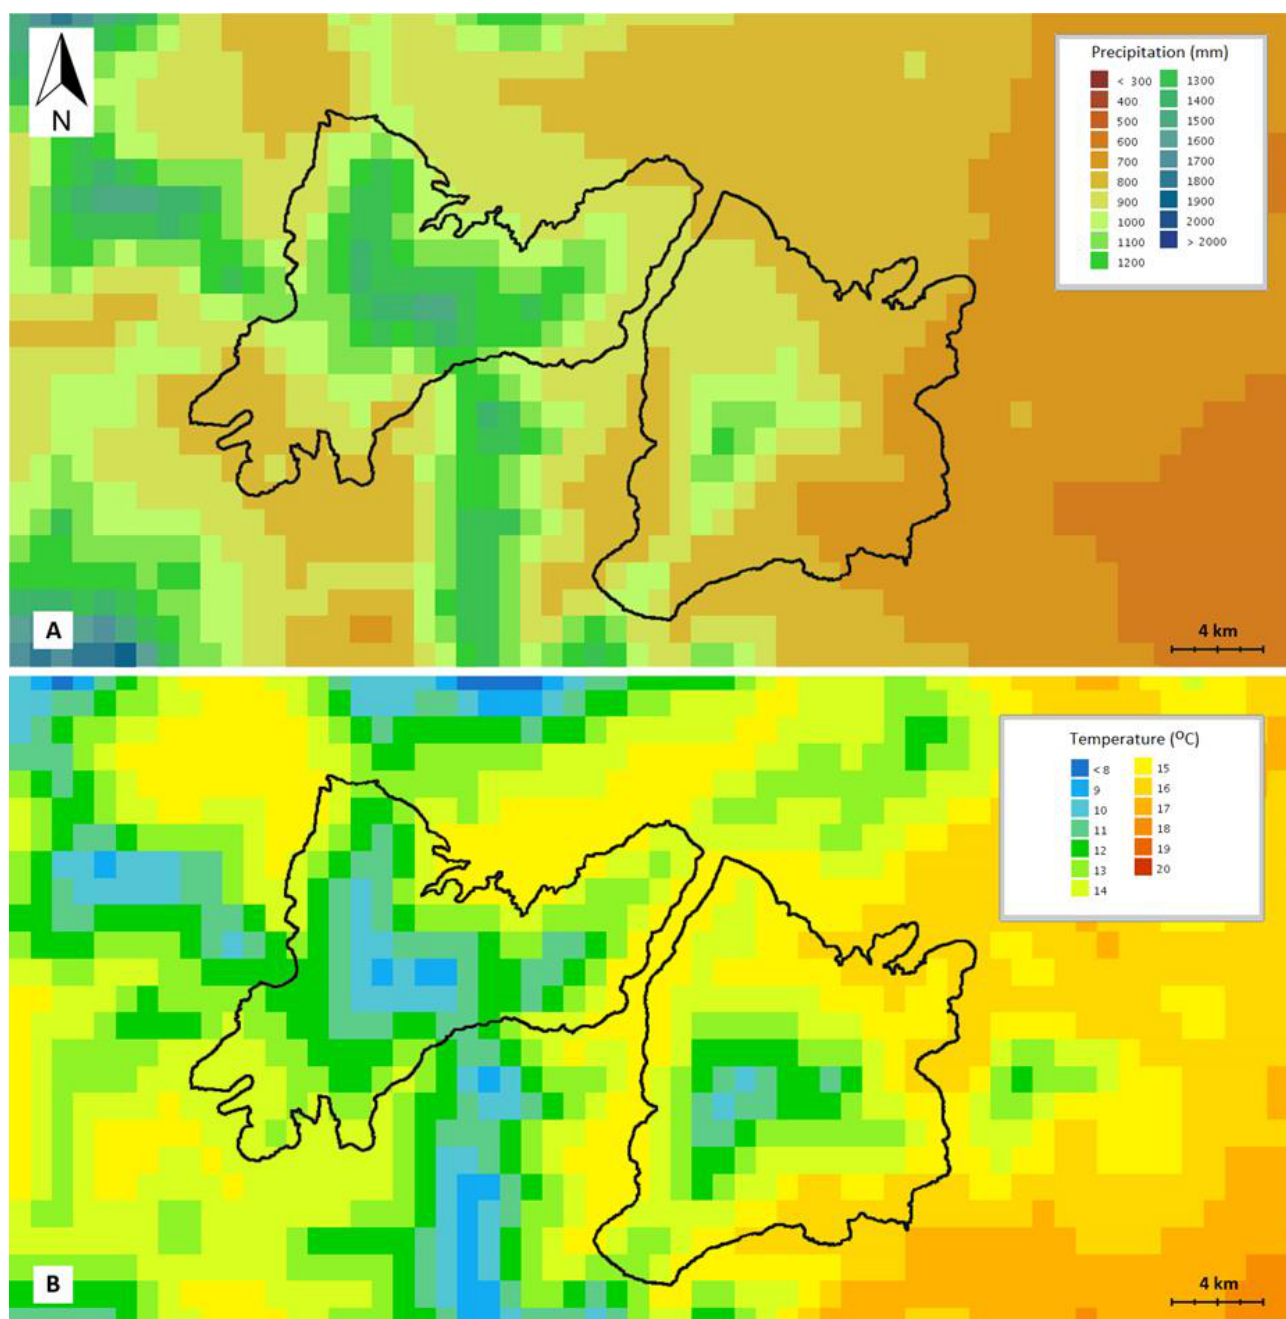
Figure 10. Excerpt of the Climatic Atlas of Greece 1971–2000, according to the Hellenic National Meteorological Service [33]: ( A ) Mean annual precipitation [mm], ( B ) Mean annual temperature [°C]. the Black line indicates the location of Mts. Oligirtos ( left ) and Farmakas ( right ).